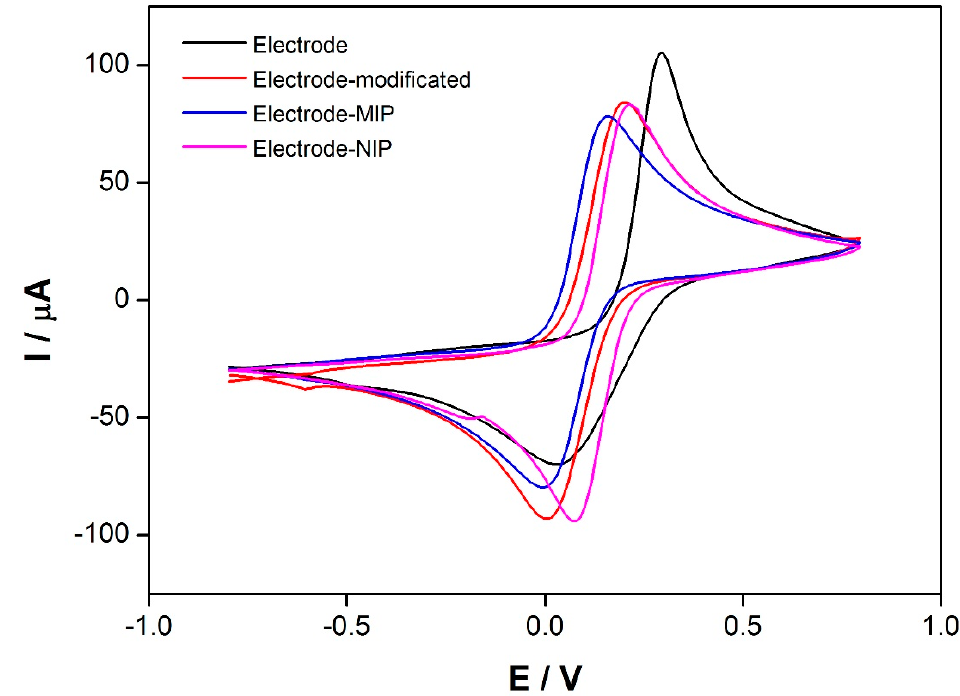
Figure 2. Characterization by CV of screen-printed gold electrodes in solution of 2 mM K 3 [Fe(CN) 6 ] in H 2 SO 4 . Bare gold electrode (black), 6-mercaptohexanol-modified gold electrode (red), NIP-electrode (pink), and MIP-electrode (blue).